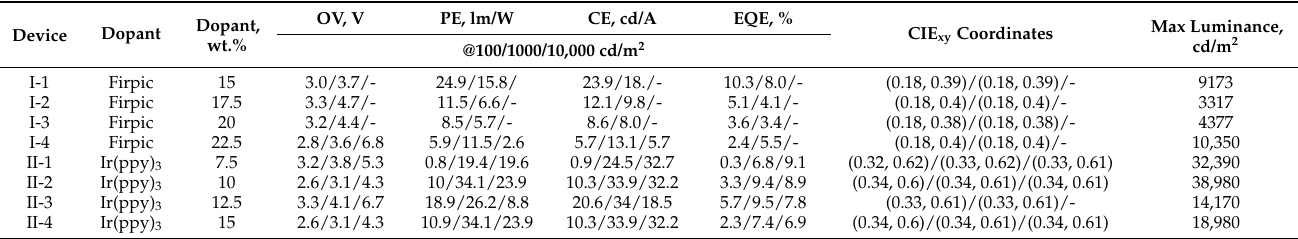
Table 1. Characteristics of devices with host H2 with Ir(ppy) 3 and FIrpic